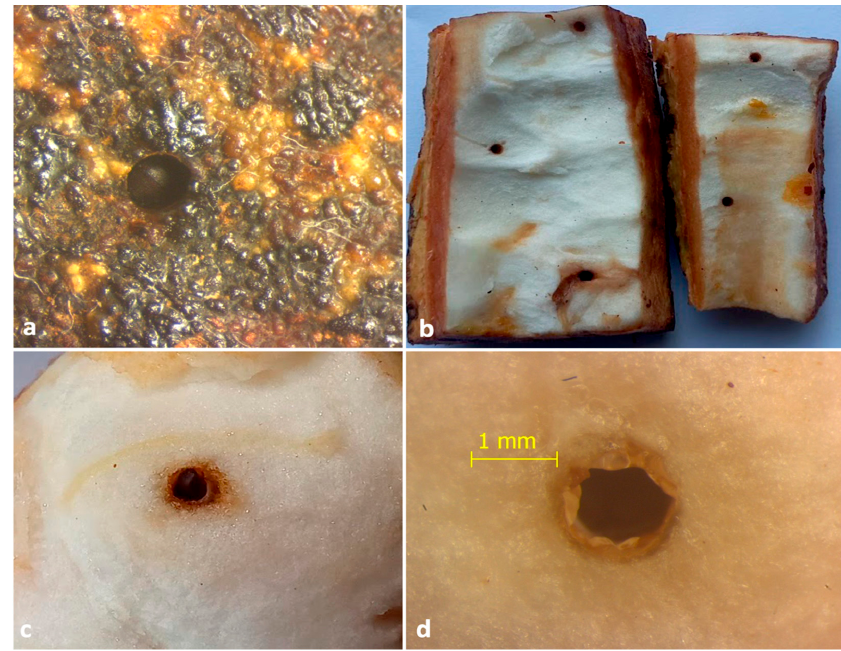
Figure 5. ( a ) Entrance hole of X. crassiusculus ; beetle closing the entrance of the gallery with its elytral declivity visible; ( b ) view of the inside of the rind of a cocoa pod showing the entrance holes surrounded by brown tissue; ( c ) view of the gallery on the mucilage tissue of the fruit; ( d ) close view of the gallery showing the necrotic brown tissue.